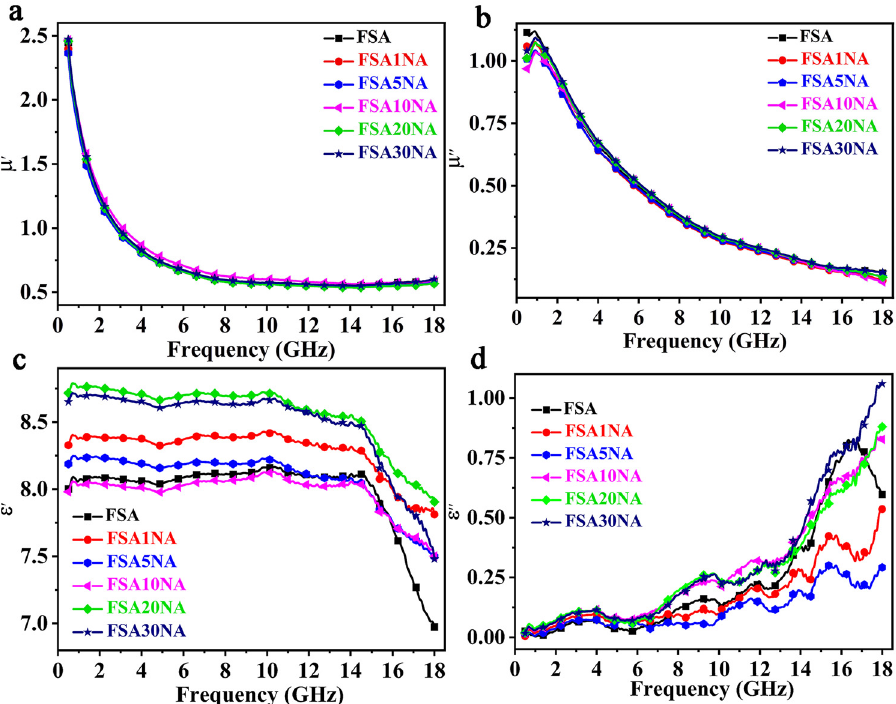
Figure 4: Frequency dependence of electromagnetic parameters of FSA, FSA1NA, FSA5NA, FSA10NA, FSA20NA, and FSA30NA. ( a ) Real part and ( b ) imaginary part of complex permeability. ( c ) Real part and ( d ) imaginary part of complex